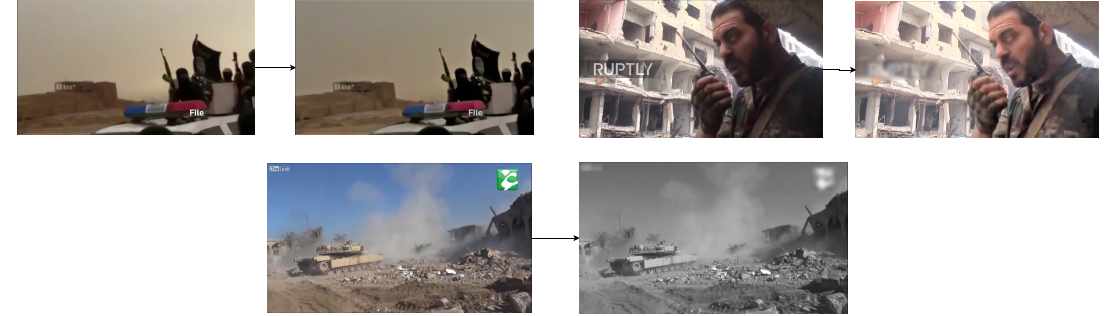
Figure 2. Frame examples.